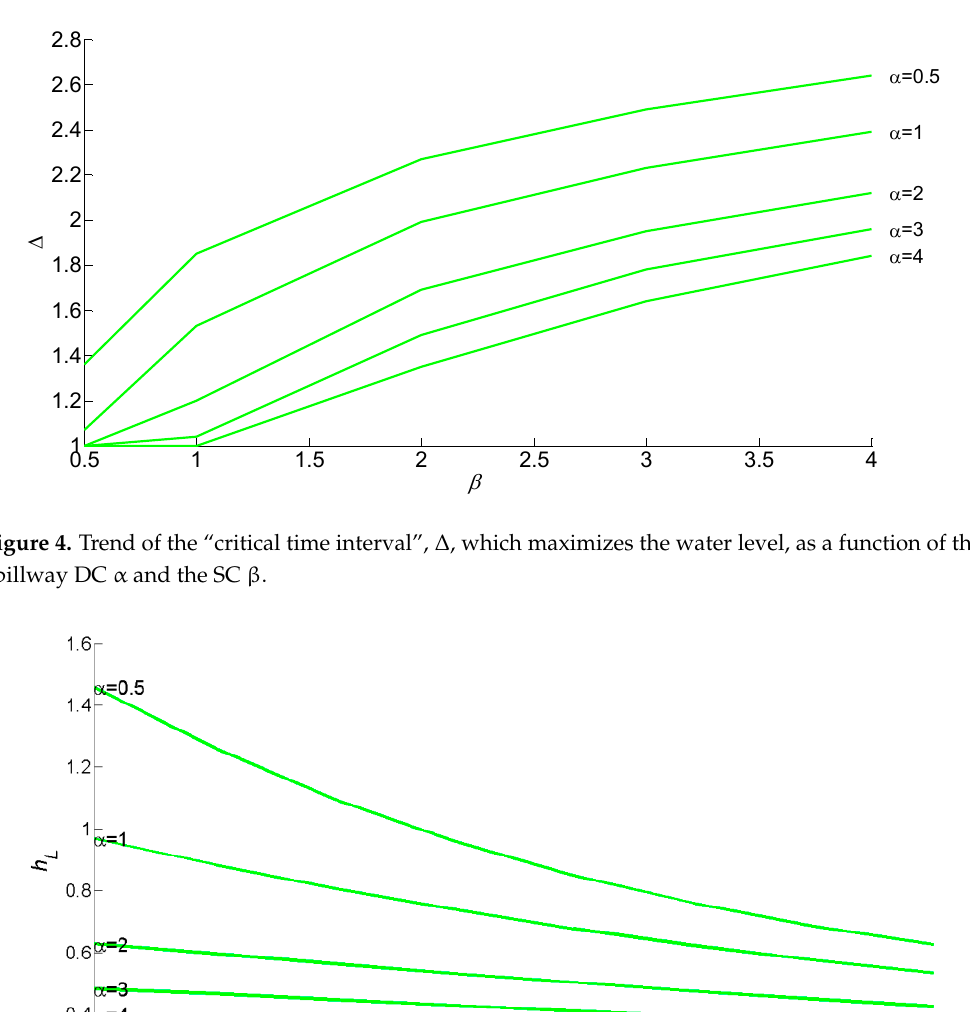
α and the L ) as a function of the spillway DC